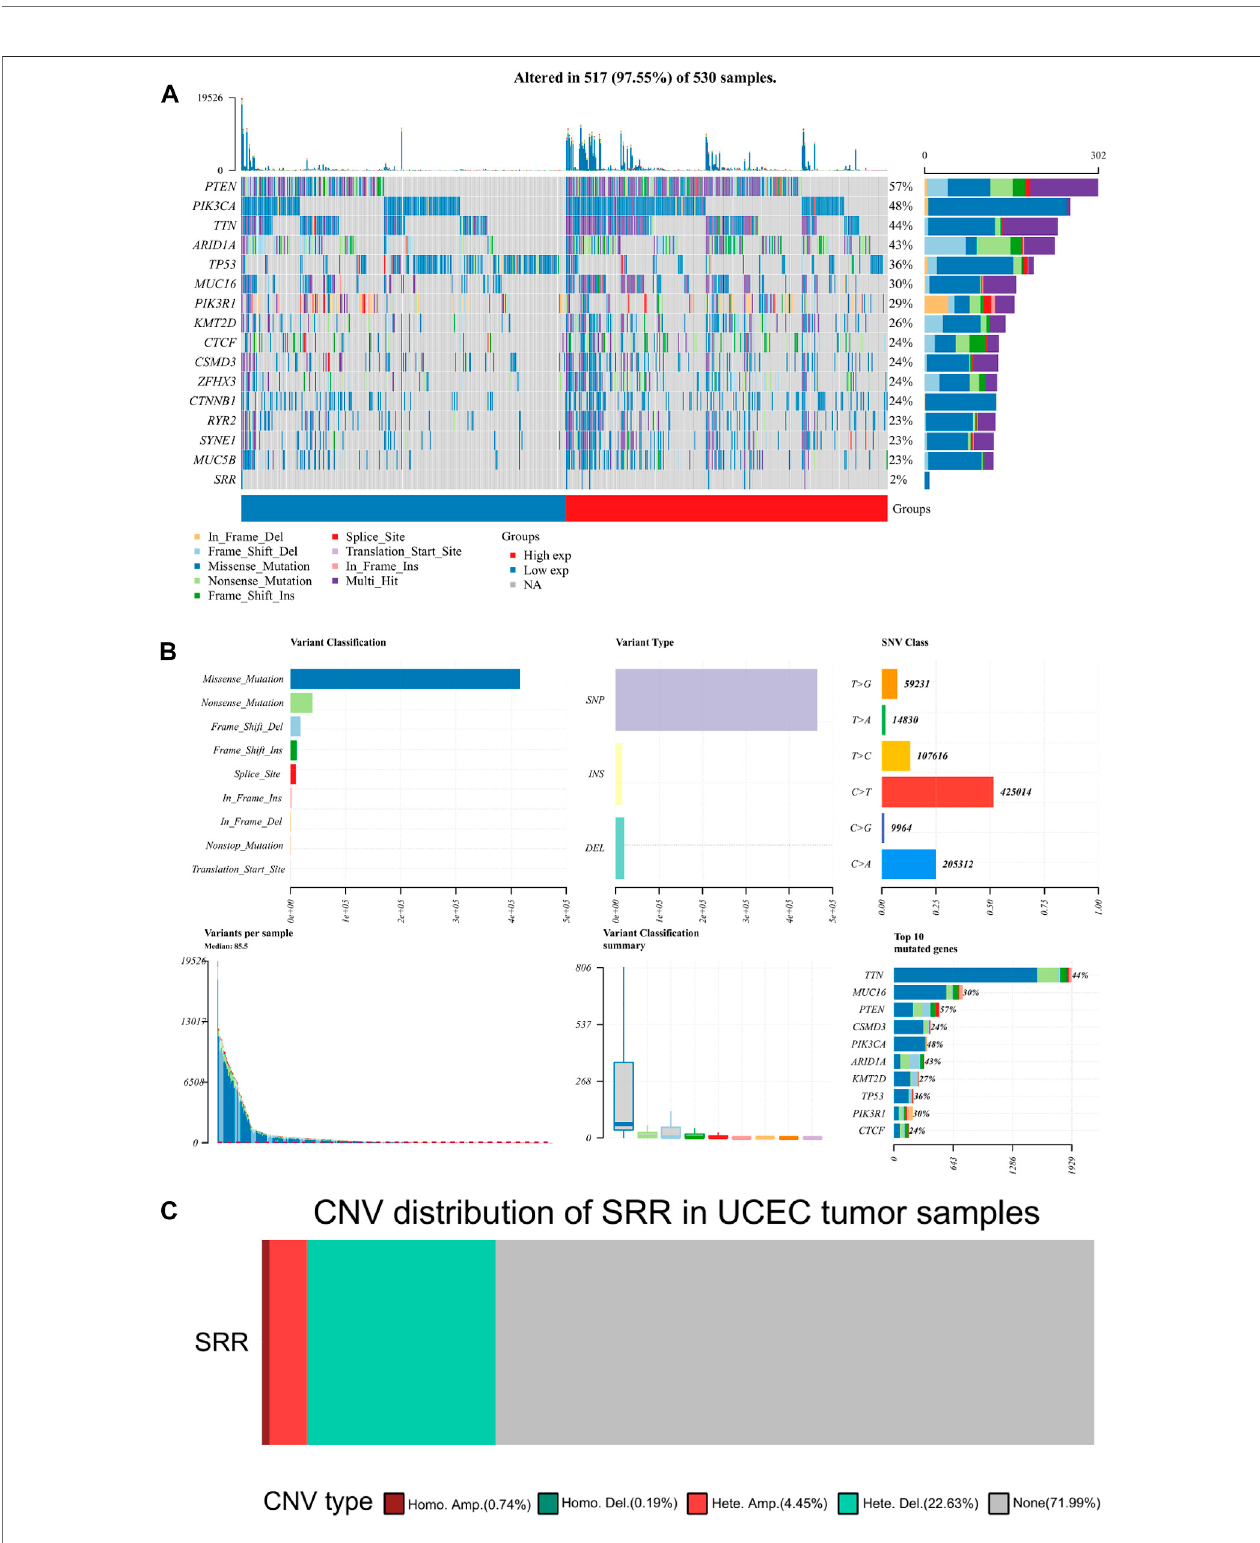
FIGURE 7 | Mutation and copy number variation of SRR in UCEC. (A) Oncoplot displaying the somatic landscape of the UCEC cohort. Genes are ordered by their mutation frequency, and samples are ordered according to SRR expression indicated by the annotation bar (bottom). The waterfall plot shows the mutation information of each gene within each sample. (B) Cohort summary plot displaying the distribution of variants according to variant classi fi cation, type, and SNV class. The lower part depicts mutation loadfor each sampleand variant classi fi cation type. A stacked bar plot shows the top10 mutated genes. (C) Thedistribution ofSRRCNV type in UCEC patients. Different colors represent different CNV